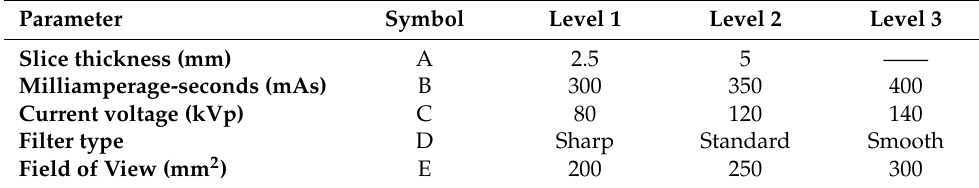
Table 1. Brain CT parameters and their levels.